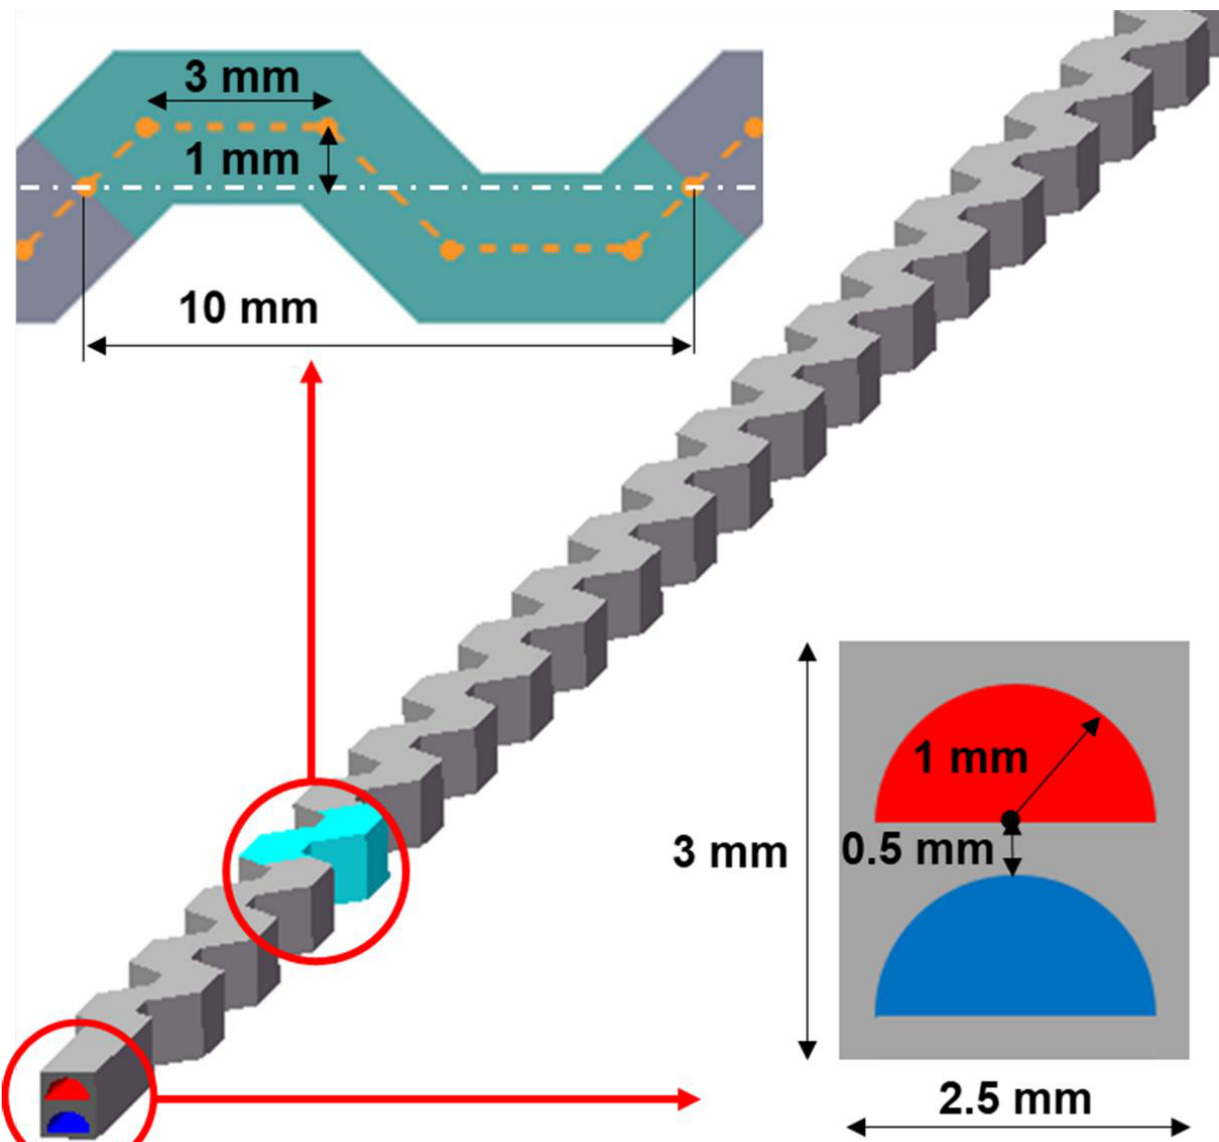
Figure 2. Unit model of channel structure for the numerical simulation.